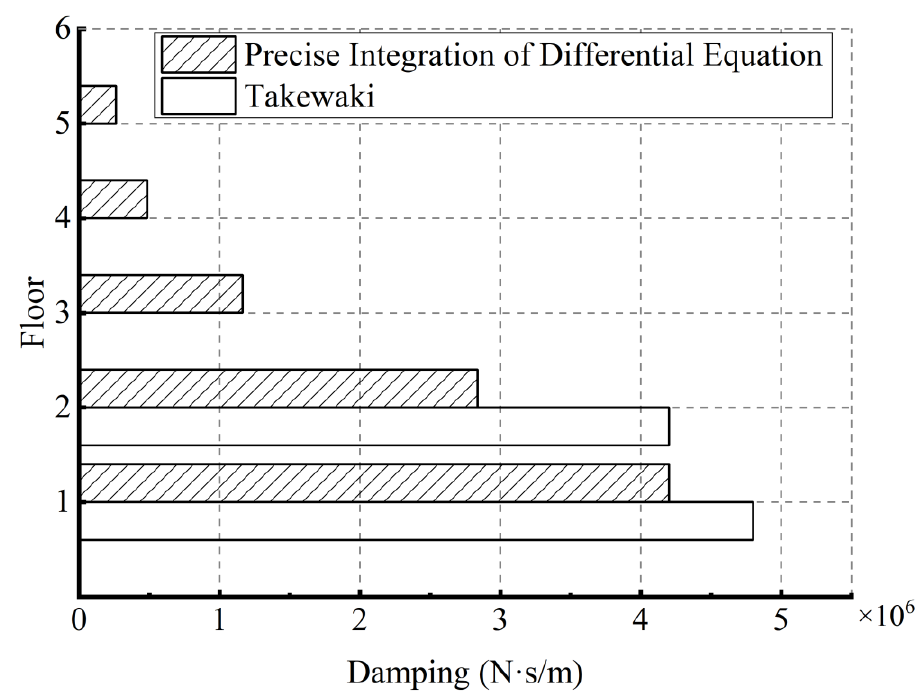
Figure 5. Six-story shear frame: distribution of damping coefficient by different response calculation methods [25].